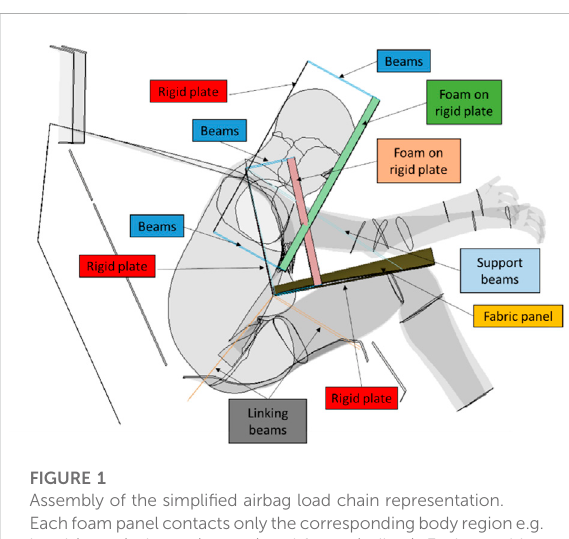
FIGURE 1 Assembly of the simpli fi ed airbag load chain representation. Eachfoampanelcontactsonlythecorrespondingbodyregione.g. head (green), thorax (orange) and femur (yellow). Each panel is connected to a rigid plate (red) via beams (blue). The head and thorax panel are connected to the femur panel via support beams(lightblue).Theentireconstructionisconnectedtotheseat structure via linking beams (grey) to keep the generic airbag in